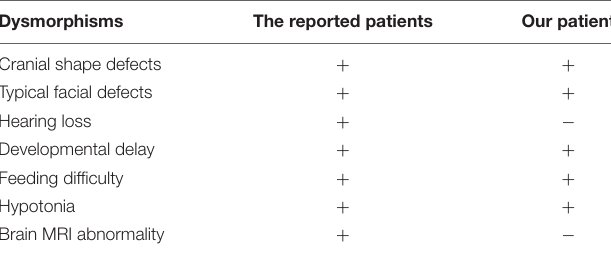
TABLE 1 | The clinical comparison of our patient and the patients reported